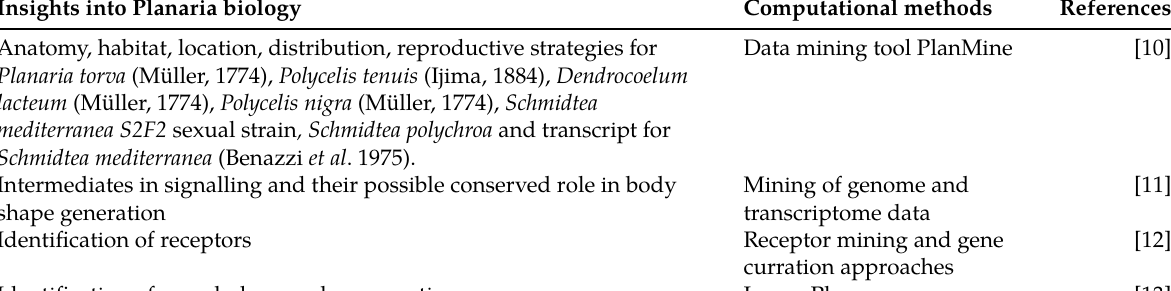
Data mining tool PlanMine Mining of genome and transcriptome data curration approaches high-throughput image analysis and information extraction software based on self-parameterizing adaptive thresholding algorithm and automated pipeline Manually currated The Schmidtea mediterranea integrate in a single web-accessible portal all available